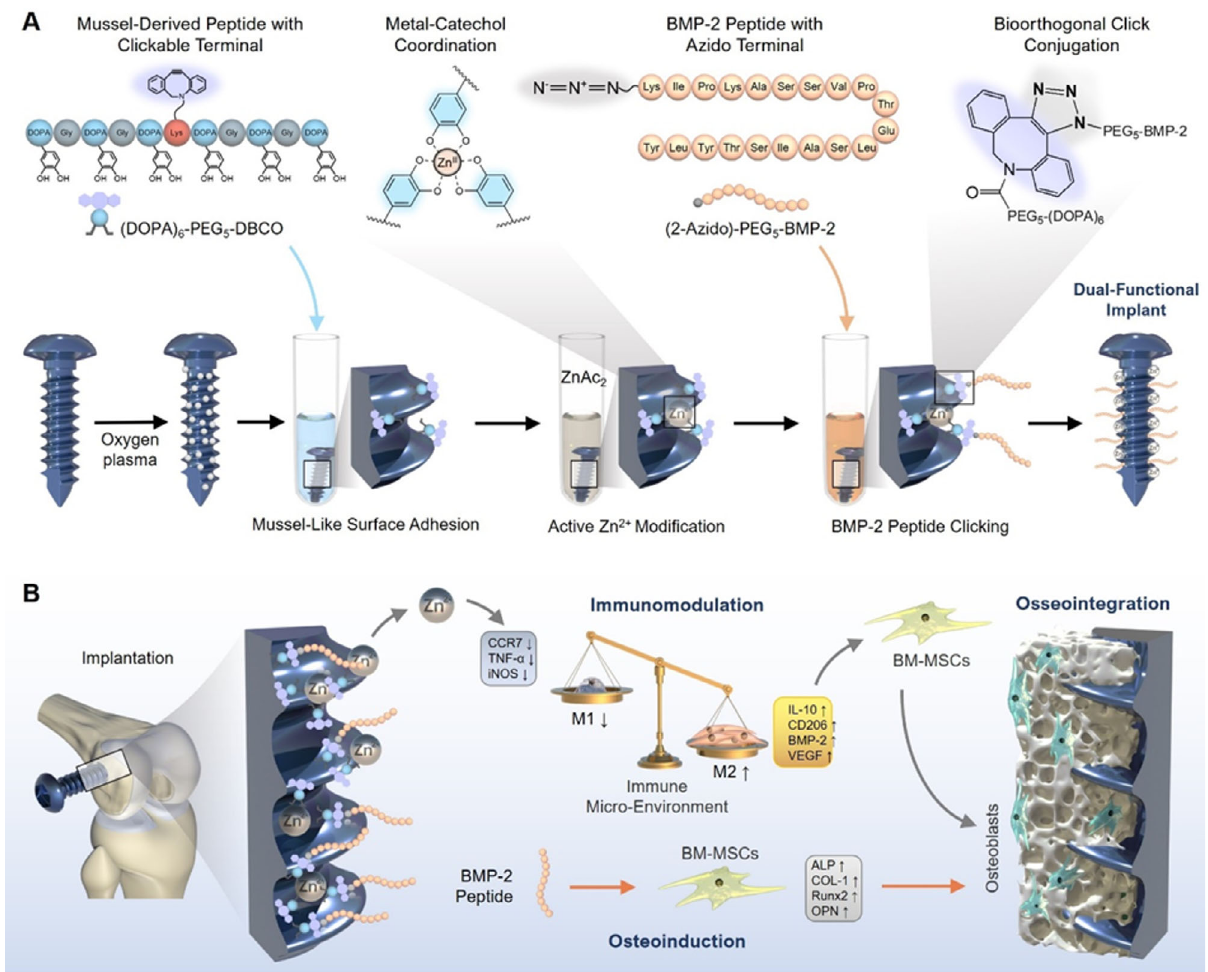
Fig. 1 Design strategy for engineering immunomodulatory and osteoinductive implant surfaces. A Schematic illustration of the mussel-derived peptide for ion coordination and biomolecular click conjugation on a medical Ti screw. B In a bone implant model, the Zn 2 + and BMP-2 peptide co-modi fi ed Ti screw shows osteoinductive and immunomodulatory dual functions in vivo, synergistically enhancing the interfacial osteogenesis and the intra-bone implant integration after